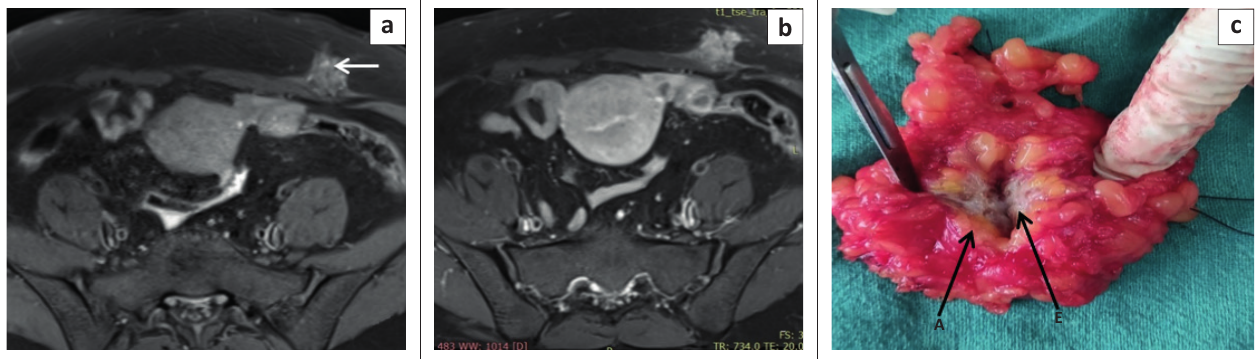
FIGURE 3: Axial pre-contrast fat suppressed T1 W image (a) shows a hyperintense area of haemorrhage (arrow) within the lesion (a) with heterogeneous enhancement on the post contrast image (b). Post-resection surgical specimen (c) shows endometriotic scar tissue (E) with surrounding adipose tissue